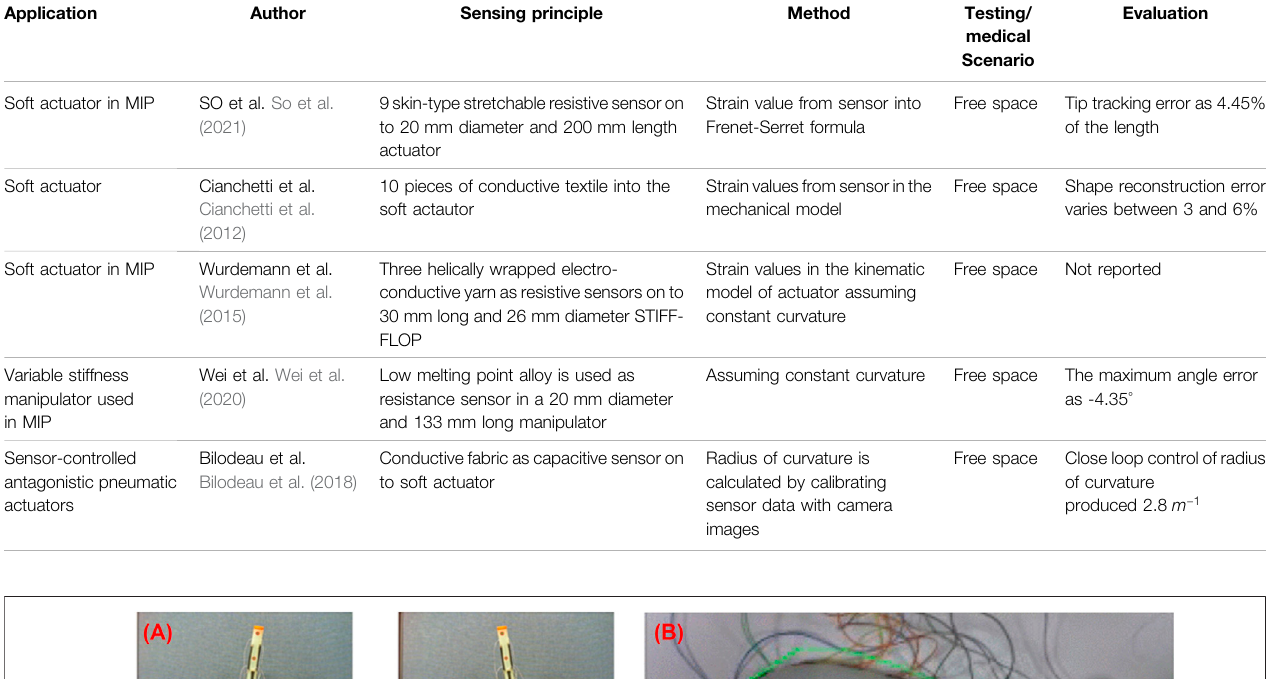
TABLE 3 | Summary of passive stretchable sensor-based shape reconstruction process.